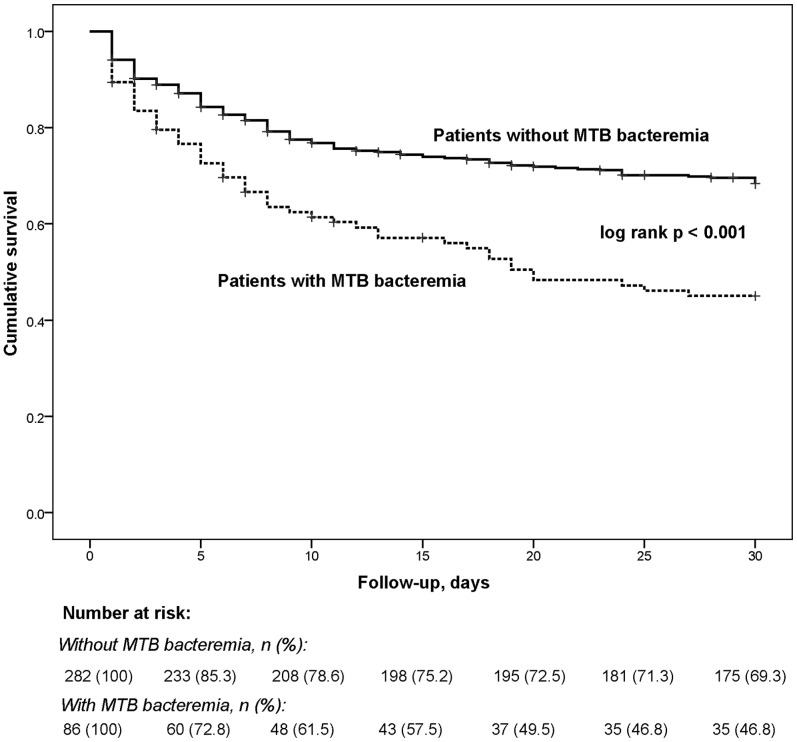
Kaplan-Meier survival curves comparing 30-day mortality between patients with MTB bacteremia and patients without MTB bacteremia.